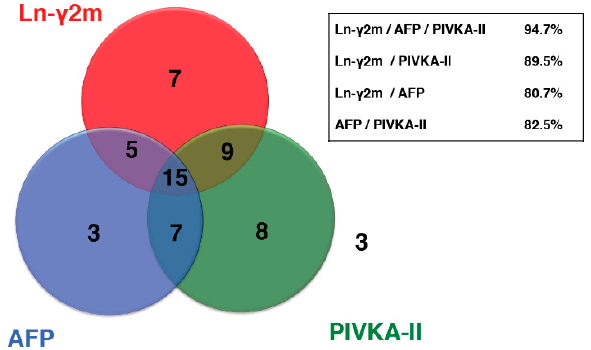
Figure 8. Serum monomeric Ln- γ 2 levels were measured in 57 patients with HCC. HCC positive rates, obtained when combining two biomarkers, were compared. Three patients were negative for all three Figure 7. ROC curve AUC of monomeric Ln- γ 2, PIVKA-II, and AFP in patients with HCC versus biomarkers. HCC detection rates for the combination of Ln- γ 2 and PIVKA-II, Ln- γ 2 and AFP, and healthy volunteers. Figure 7 is modified from Kiyokawa et al. [22]. PIVKA-II and AFP, were 89.5% (51/57), 82.5% (47/57), and 80.7% (46/57), respectively. A combination of all three markers was detected in 54/57 patients (94.7%). Figure 8 is modified from Kiyokawa et al. [22].